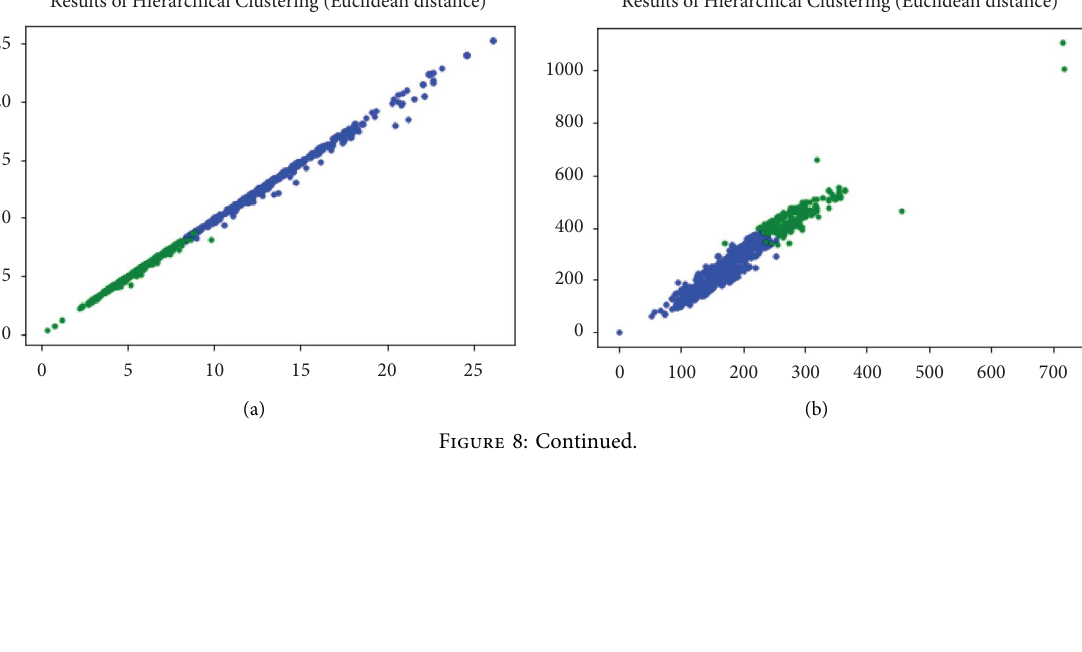
Figure 7: Clustering results of the k -means clustering method. (a) Feature vector f vector f h